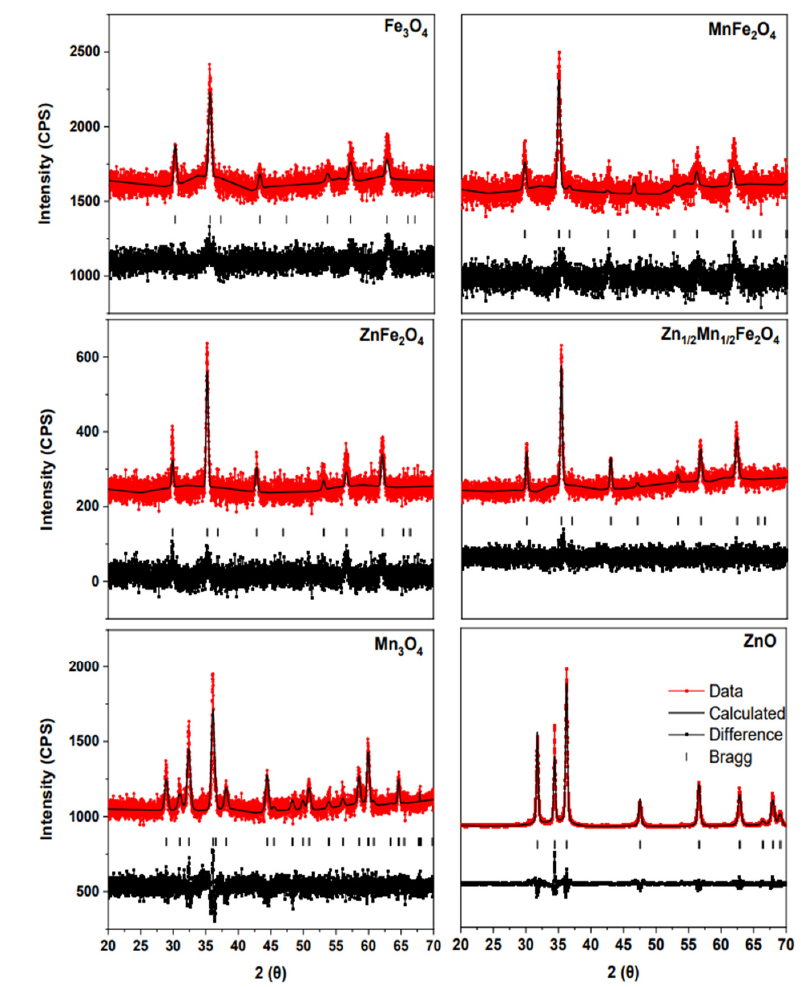
Figure 1. Fitted X-ray diffraction pattern for Fe 3 O 4 , MnFe 2 O 4 , ZnFe 2 O 4 , Zn 0.5 Mn 0.5 Fe 2 O 4 , Mn 3 O 4 and ZnO.